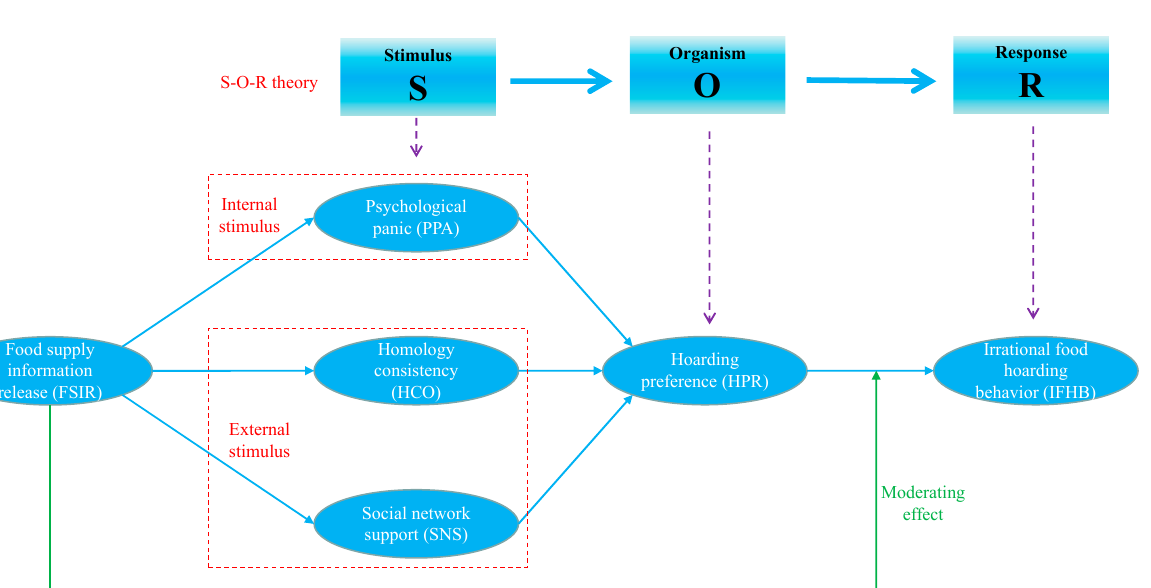
Figure 1. Food waste caused by IFHB.